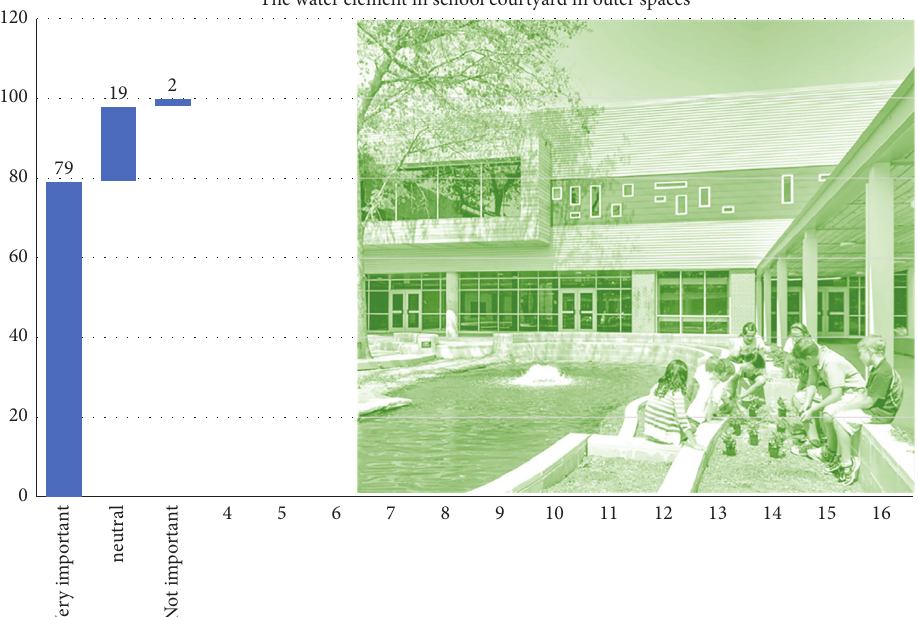
Figure 9: The water element in the school